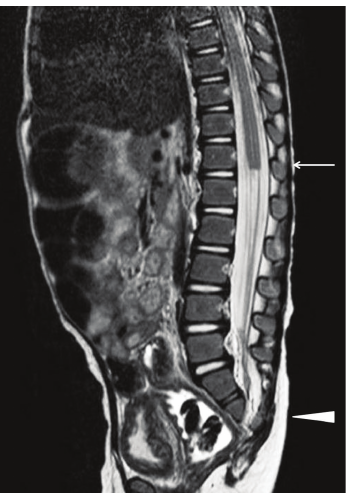
Figure 1: MRI showed the absence of the sacral bone under S2 and distal lumbar vertebrae (arrowhead). The level of the spinal cord terminus was situated as T-12 (arrow).